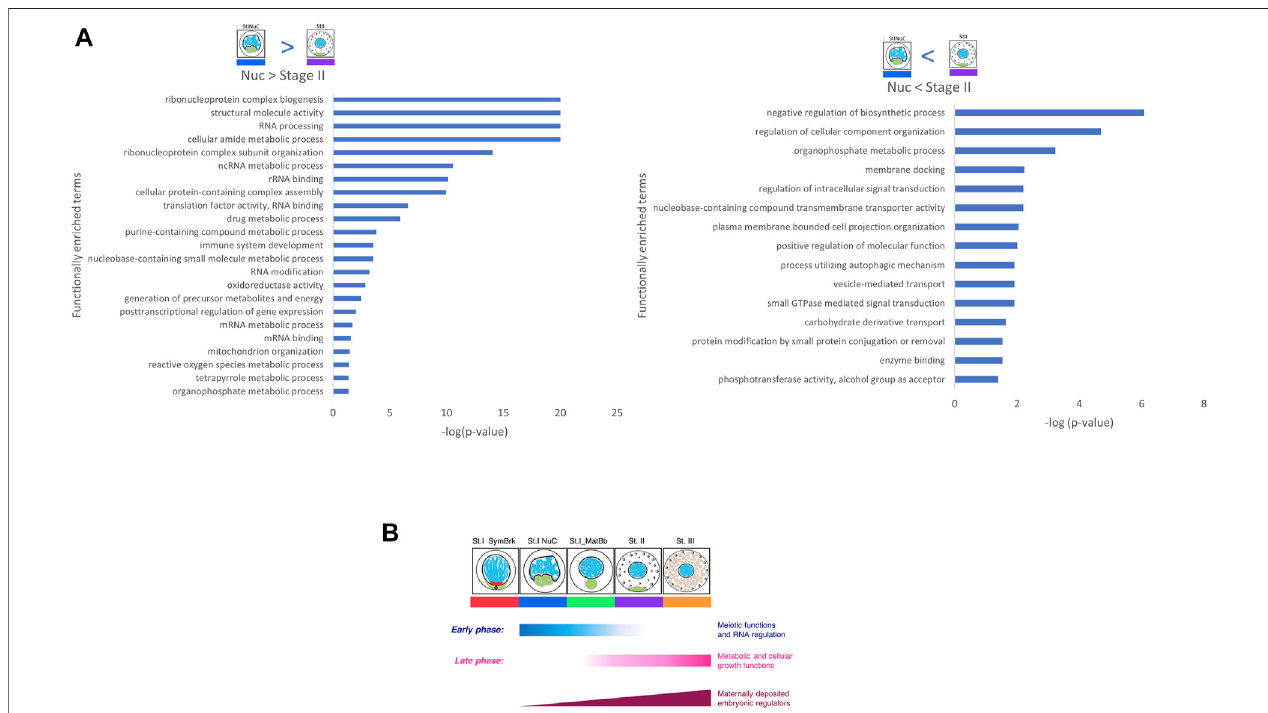
FIGURE4| Functional analysisofpairwise comparisons. (A) GenesthatwereupregulatedinNucover StageIIshowmany RNAfunctions,and genesthatwereup regulatedinStage IIover Nucshowmany biosynthesis,metabolic and membrane processes. (B) Aschemeshowing twophases ofprominentdifferentiation activities in oogenesis determined by functional analysis of clusters and pairwise DEGs. The early phase includes mostly meiotic functions and RNA processing and regulation. The late phase includes mostly metabolic and cellular growth functions. Maternal embryonic regulators gradually increase their expression in parallel to these two